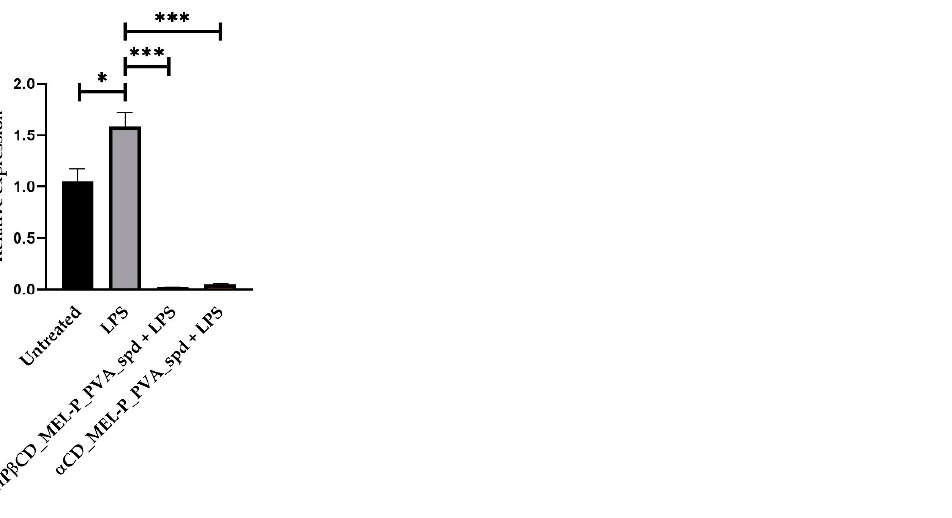
Figure 12. Relative expression of IL-1b. (level of significance: * p < 0.05, *** p < 0.001)